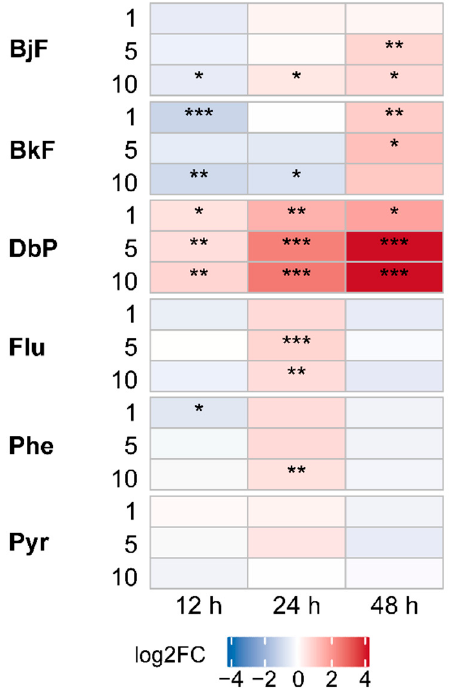
Figure 6. Quantitative analysis of H2AX phosphorylation presented as heatmap. Based on fluorescence images, fluorescence intensity was quantified. Following, fold induction over DAPI signal was calculated and referred to solvent control. Data were then log2 - transformed (log2FC). An increase in H2AX phosphorylation is indicated by red shades, a decrease by blue shades. Statistical analysis was performed with Student’s t -test ( n = 3, * p ≤ 0.05, ** p ≤ 0.01, *** p ≤ 0.001). Fold changes and standard deviations can be found in in the Supplementary Materials “Underlying Data”.